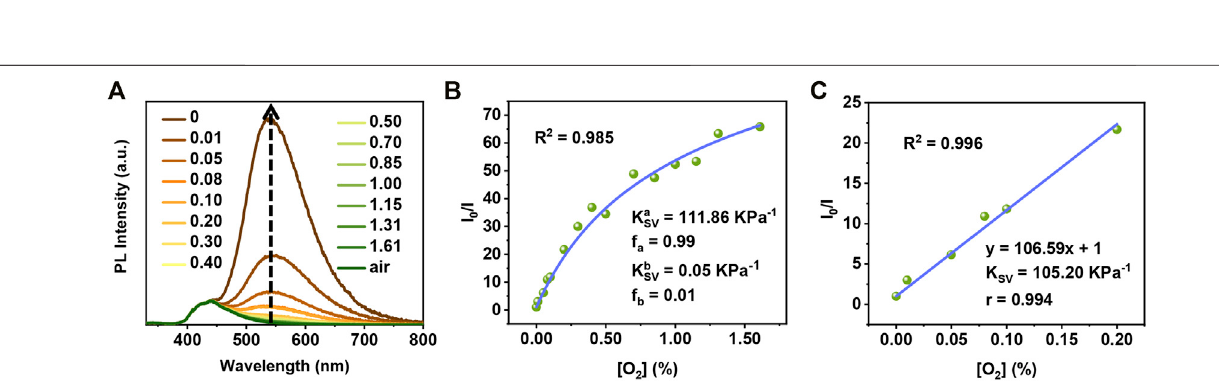
Frontiers in Chemistry |